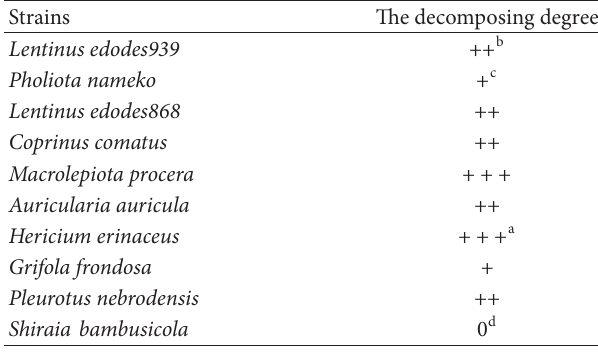
Table 2: The decomposing degree of 10 strains on filter paper.